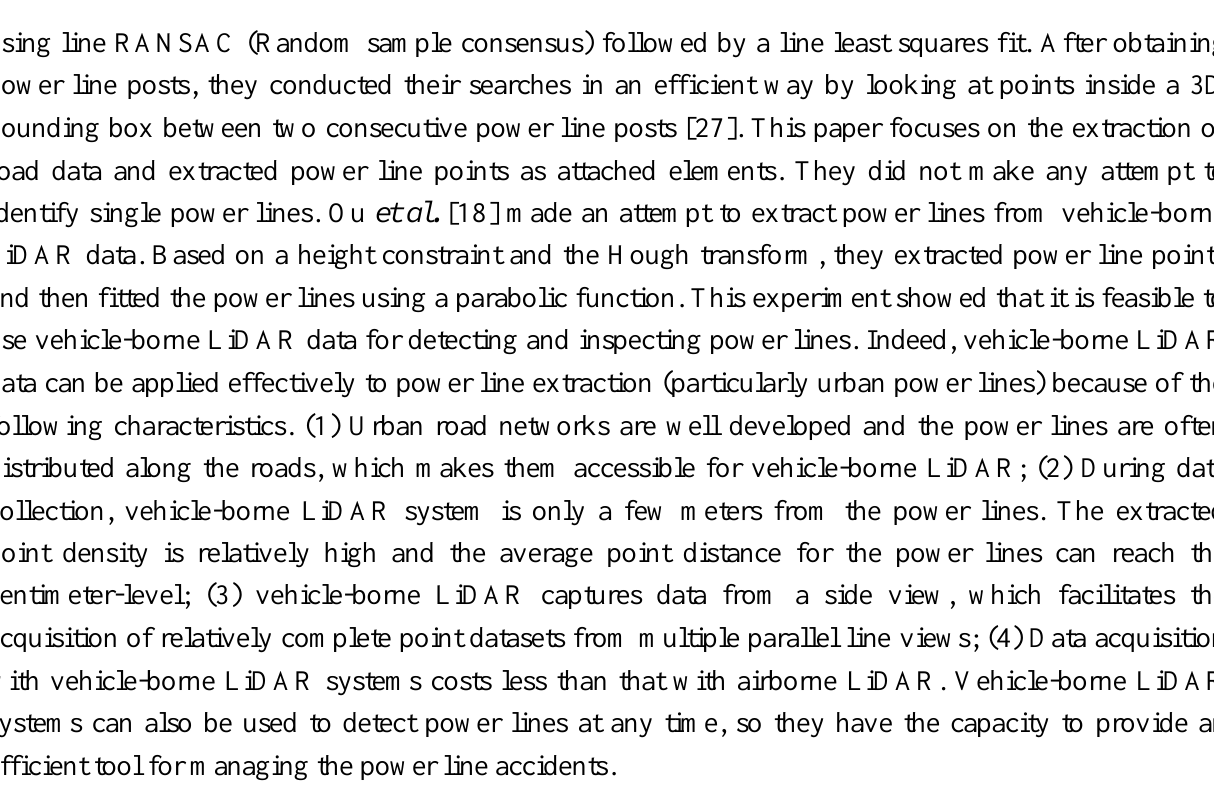
Figure 1. Example of a multiple parallel power line structure. Cross ArmInsulator